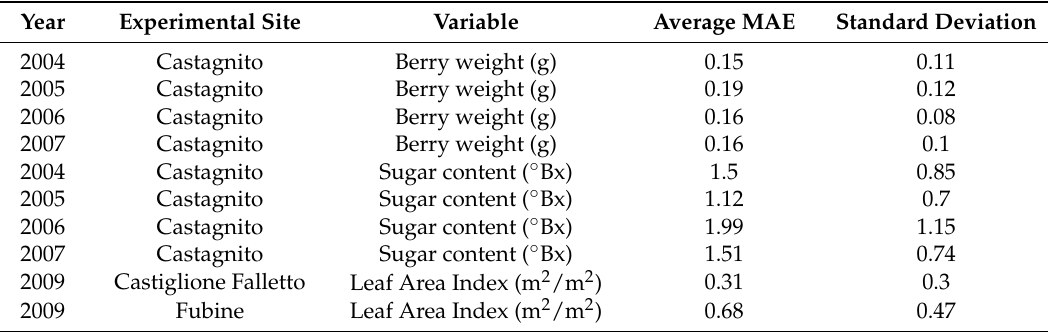
Table 4. Comparison between simulated and measured values of LAI , berry weight, and sugar content at Fubine. MAE: Mean absolute error.